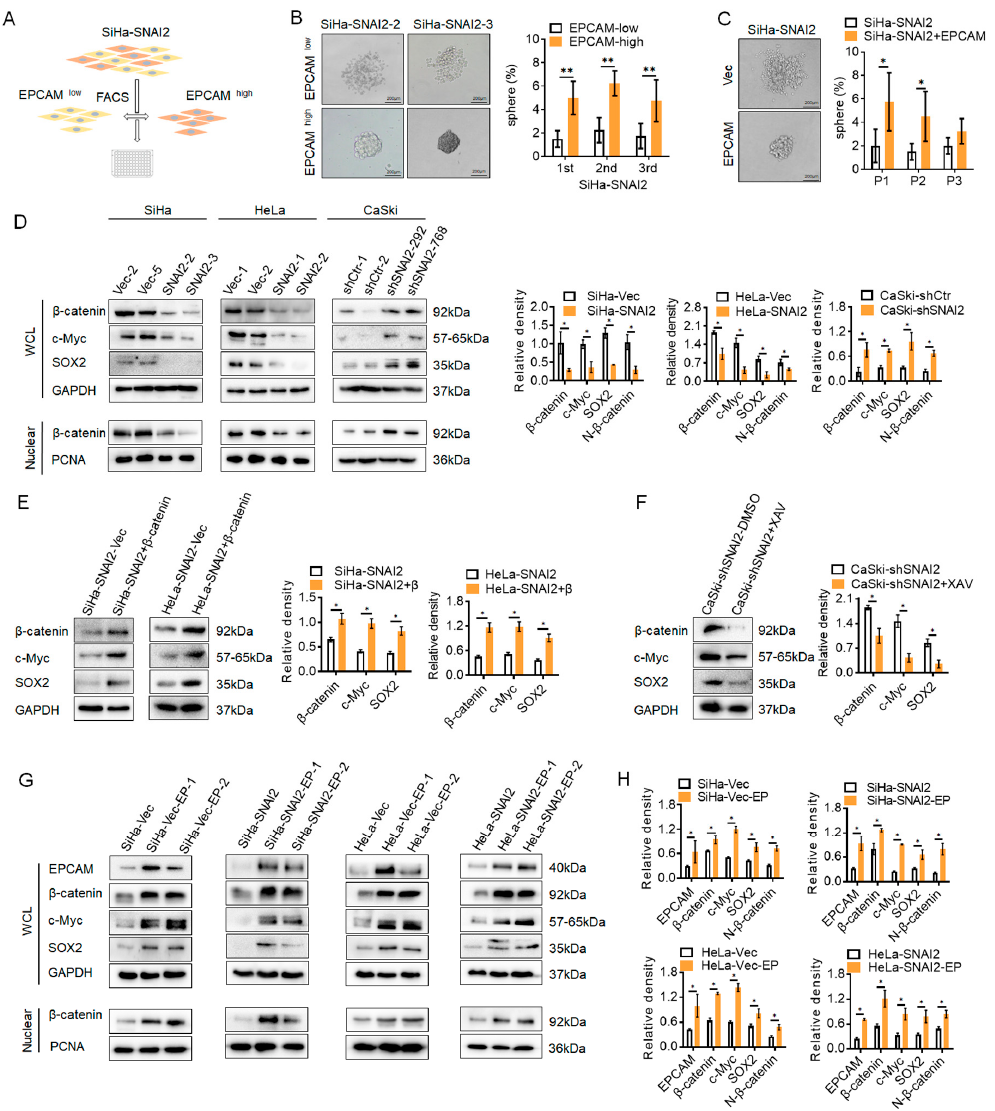
Figure 4. SNAI2 suppressed the nuclear translocation of β -catenin. ( A ). The EPCAM high and EPCAM low cells were sorted by FACS from SiHa-SNAI2 cells. ( B ). The number of tumorspheres formed by SiHa-SNAI2-EPCAM high and SiHa-SNAI2-EPCAM low cells was counted during three consecutive passages, and the representative photos are shown. ( C ). An EPCAM recombinant plasmid was used to recover the EPCAM expression in SiHa-SNAI2 cells. The number of tumorspheres formed by SiHa-SNAI2 and SiHa-SNAI2-EPCAM cells was counted during three consecutive passages, and the representative photos are shown. ( D ). The protein levels of β -catenin, c-Myc, SOX2, and nuclear β -catenin in SNAI2-modified cells were detected by Western blotting. ( E ). Western blotting was used to detect the protein levels of β -catenin, c-myc, and SOX2 after the β -catenin expression was rescued via transient transfecting of a β -catenin recombinant plasmid in SiHa-SNAI2 cells. ( F ). β -catenin expression was blocked by using XAV939 (60 µ M/mL) in CaSki-shSNAI2 cells, and the protein levels of β -catenin, c-myc, and SOX2 were detected by Western blotting. ( G ). EPCAM expression was rescued via transient transfection of an EPCAM recombinant plasmid in SNAI2 overexpressed cells, and the protein levels of β -catenin, c-Myc, SOX2, and nuclear β -catenin were detected by Western blotting, and the quantitative analysis is shown in ( H ). * p < 0.05, ** p < 0.01, vs.